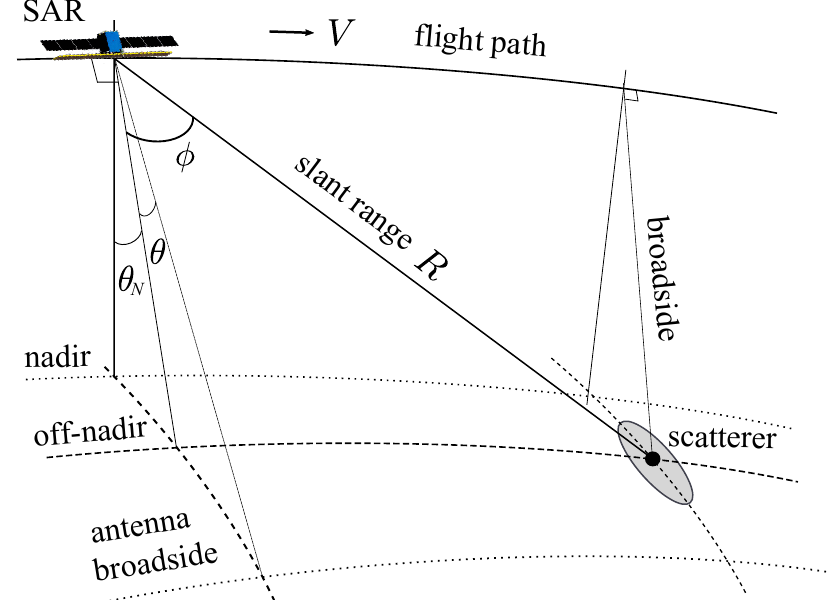
Figure 1. AMAO spaceborne SAR imaging